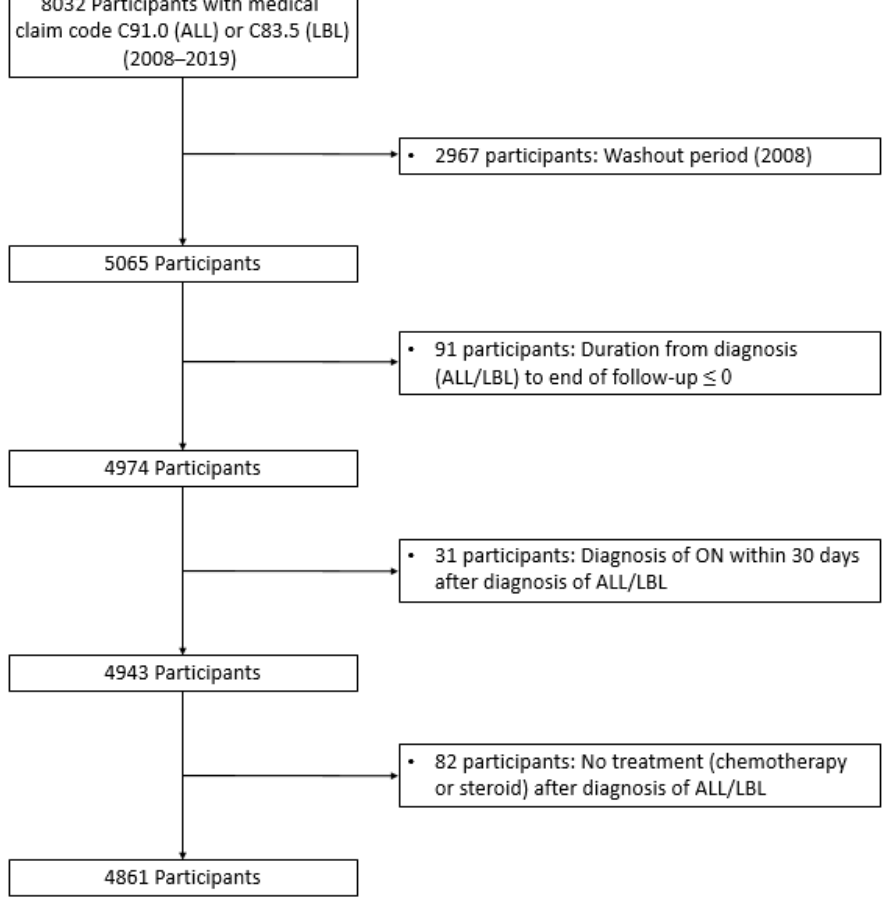
Figure 1. Participant enrolment flow diagram. Among 8056 participants, 4861 with ALL/LBL were included in the study. A total of 2967 patients were excluded owing to the washout period.